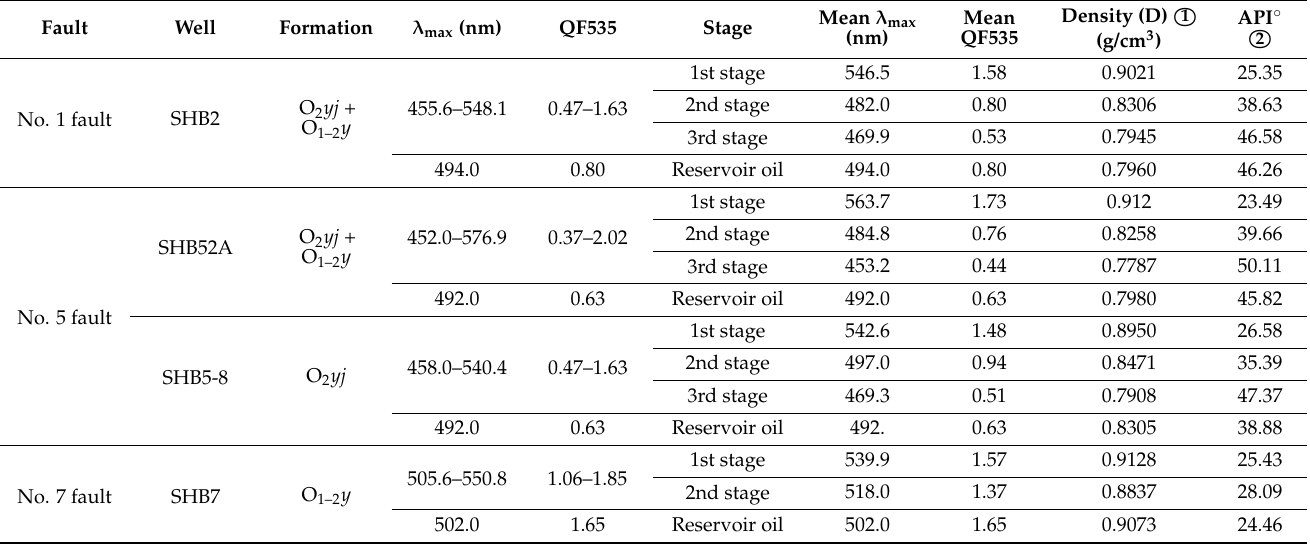
Table 1. Fluorescence spectral data of oil inclusions and reservoir